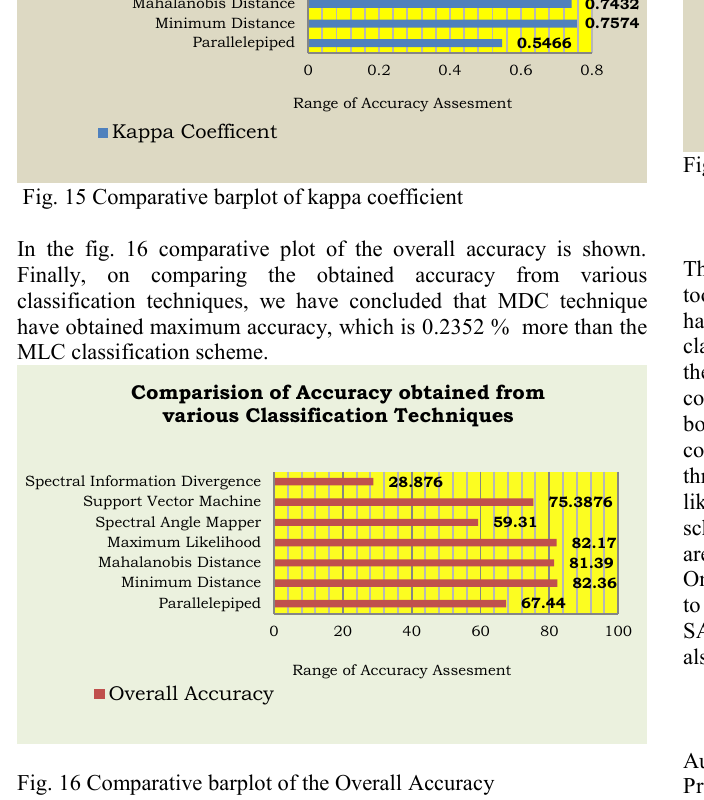
i.e. kappa coefficient is directly proportional to overall accuracy. Now we have plotted the kappa values on vertical-axis and classification accuracy on the horizontal axis. This shows that a new linear relationship is developed in between kappa coefficient and overall classification accuracy.